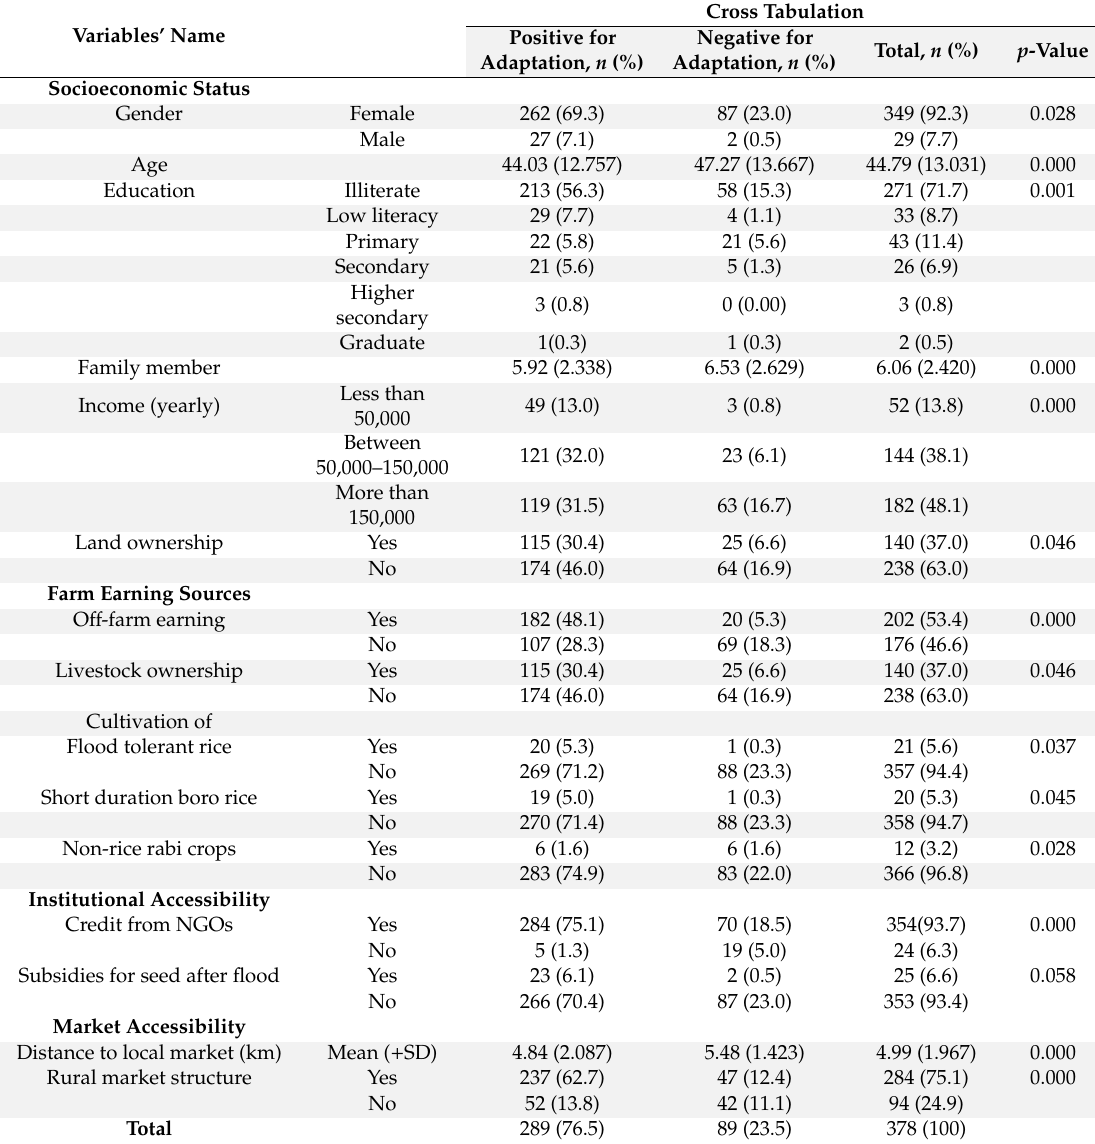
Table 3. Cross tabulation of adaptability versus socio-economic variables, farm earning sources variables, and institutional and market accessibility